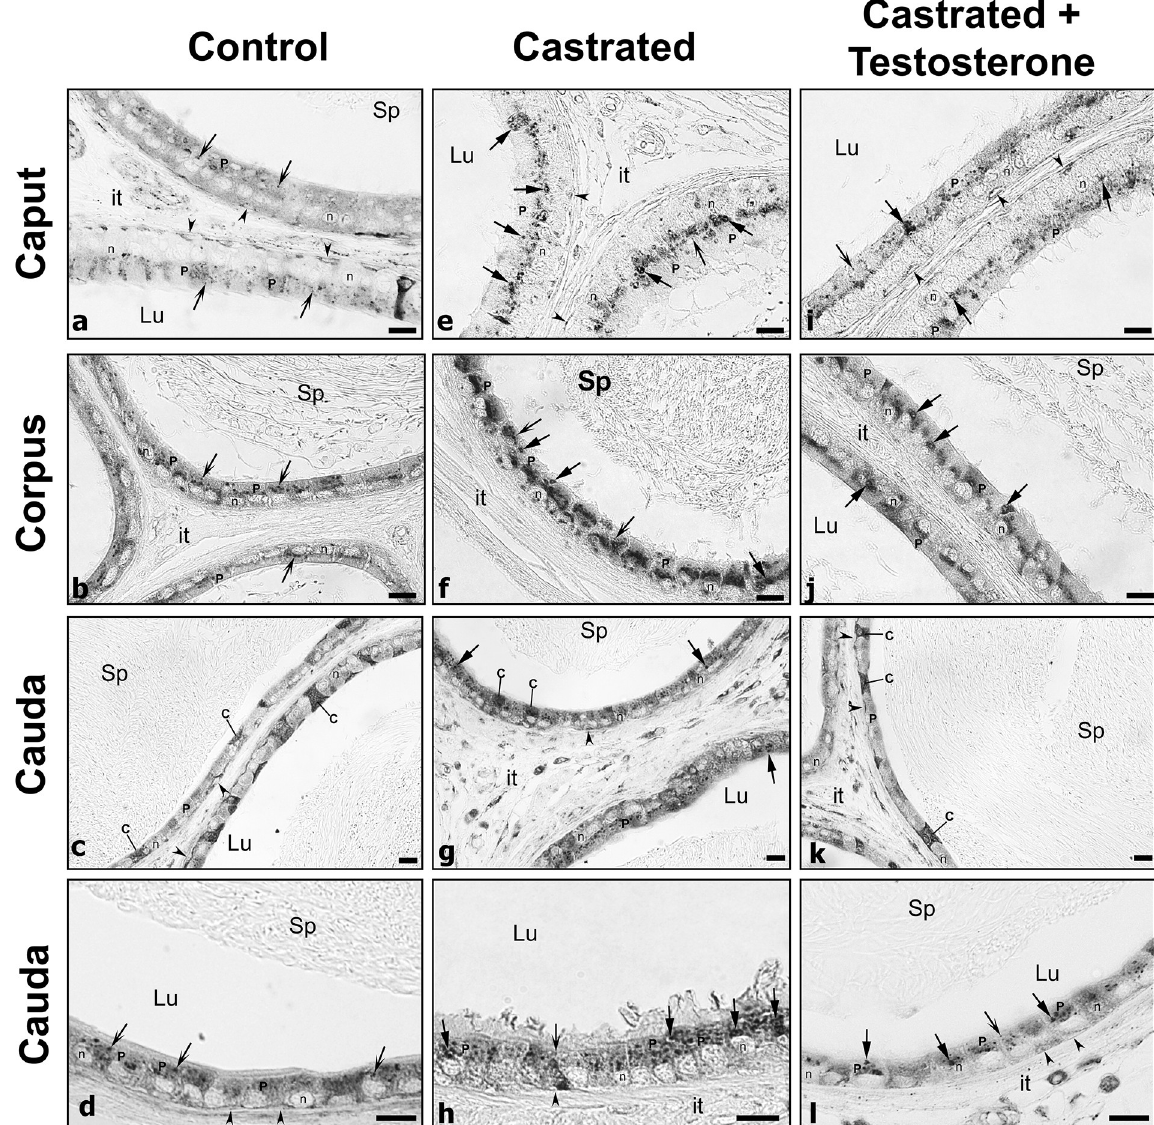
Fig 1. Immunostaining of epididymal tubules with cathepsin D of caput, corpus and cauda regions from control (Con), castrated (Ct) and castrated with testosterone supplementation (Ct+T) animals. Small dense spherical reactive lysosomes (arrows with winged head) of principal cells (P) are evident in (Con) animals. In (Ct) animals, lysosomes (arrows with triangular head) appear to be larger in size and more abundant, with some remaining large in (Ct+T) animals. Some of these lysosomes show a dense homogeneous appearance, while others show a densely stained ring enveloped by a pale central core (triangular arrows). Lu, lumen; it, interstitial space; Sp, spermatozoa; reactive basal (arrowheads) and clear cells (C); n, nuclei of principal cells. Scale bars = 20 μ m.